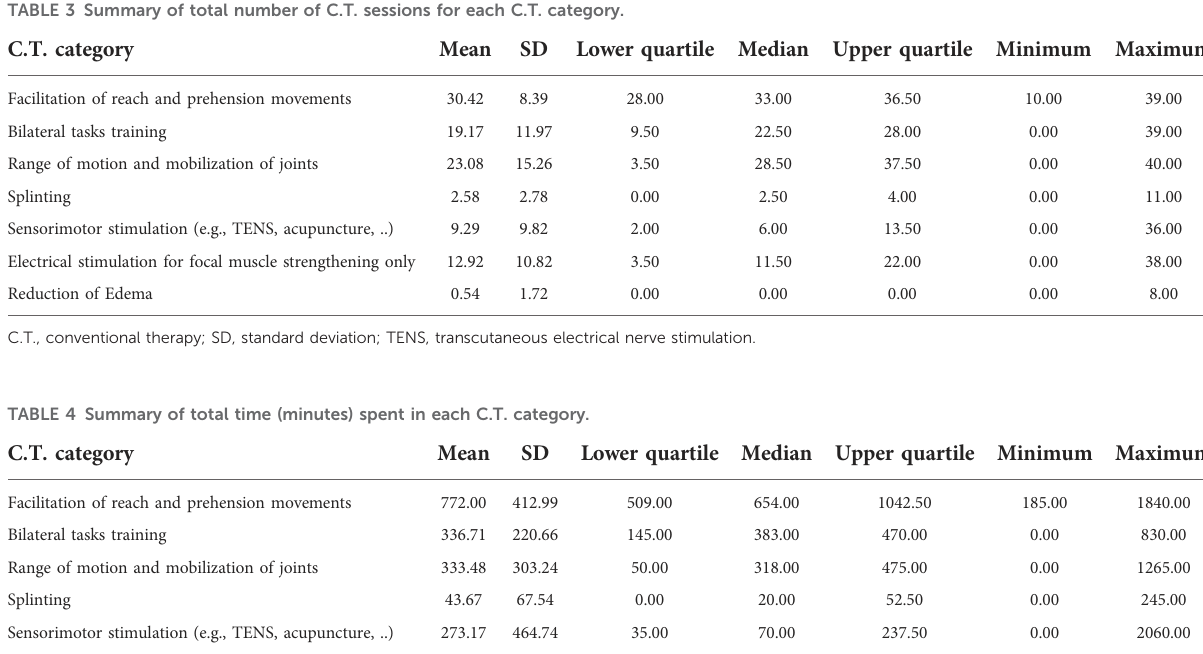
TABLE 3 Summary of total number of C.T. sessions for each C.T. category.